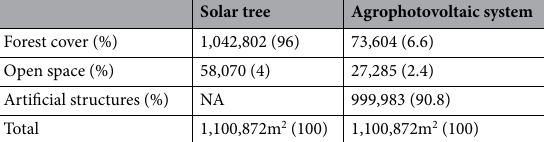
Table 4. Comparison of forest cover between the solar tree and agrophotovoltaic system (unit: m 2 ).